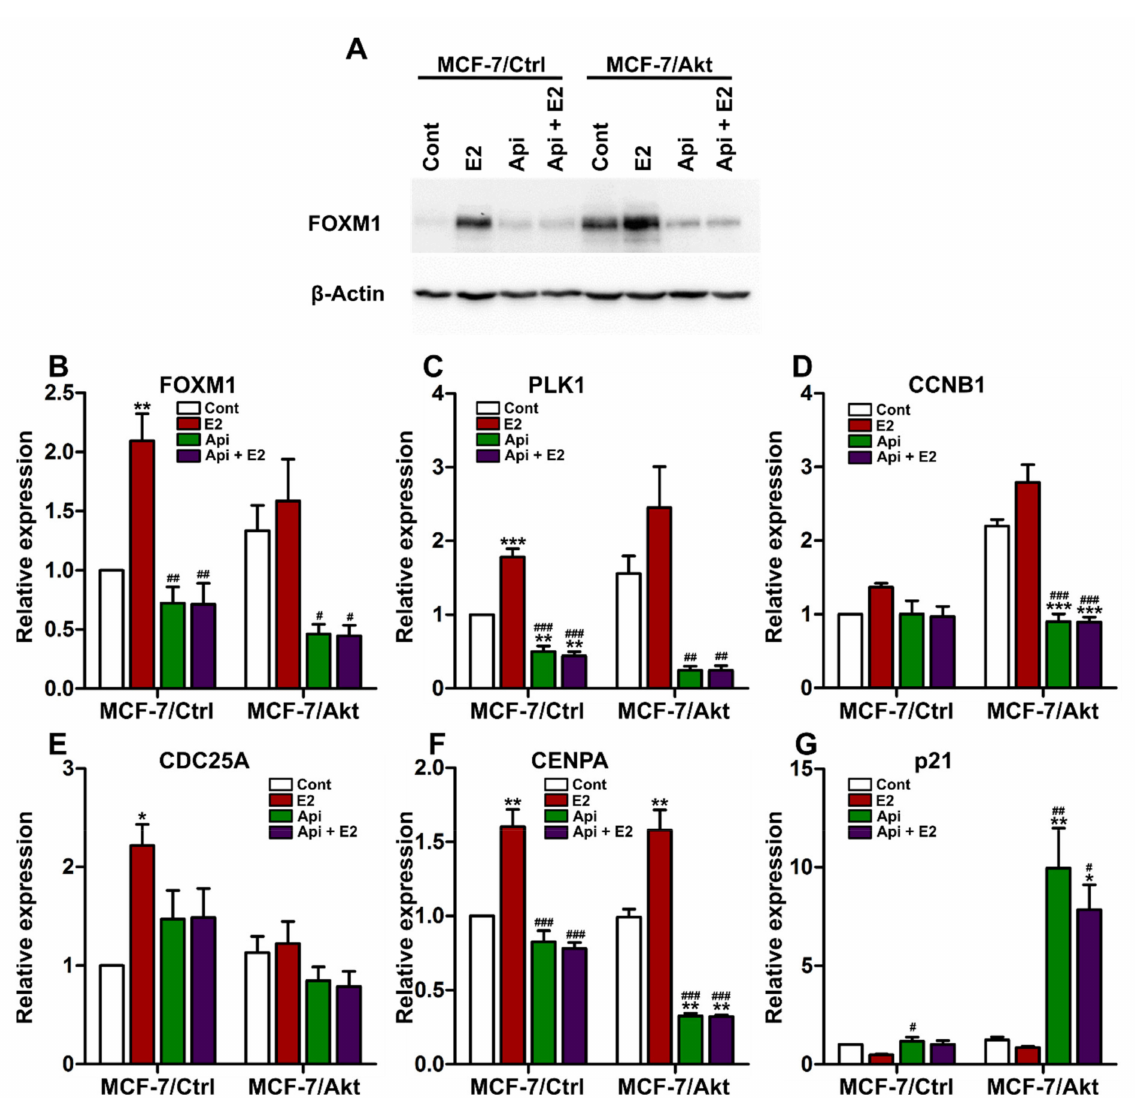
Figure 5. Apigenin inhibits the expression of FOXM1 and modulates the expression of FOXM1-related cell cycle genes. MCF-7/Ctrl cells and MCF-7/Akt cells were treated with 0.1% ( v / v ) DMSO and 0.1% ( v / v ) ethanol as the control (Cont), 1 nM estradiol (E2), or 10 µ M apigenin (Api) alone or in combination with E2 for 24 h. ( A ) Equal amounts of protein extracts from MCF-7/Ctrl cells and MCF-7/Akt cells were analyzed by Western blotting with antibodies specific to FOXM1 and β -actin. The gene expression of forkhead box M1 (FOXM1) ( B ), polo-like kinase 1 (PLK1) ( C ), cyclin B1 (CCNB1) ( D ), cell division cycle 25A (CDC25A) ( E ), centromere protein A (CENPA) ( F ) and cyclin-dependent kinase inhibitor 1A (CDKN1A/p21) ( G ) was assessed by real-time PCR and normalized to the expression of the housekeeping genes GAPDH and TBP. The experiment was conducted three times in triplicate. The results are expressed as the fold change in gene expression compared with that in the control of the MCF-7/Ctrl cells and are presented as the mean ± SEM. Statistical analyses were performed with one-way ANOVA followed by Tukey’s post hoc test. * p -value < 0.05, ** p -value < 0.01, *** p -value < 0.001 indicate significant differences from the control group in the same clone. # p -value < 0.05, ## p -value < 0.01, ### p -value < 0.001 indicate significant differences from the E2 group in the same